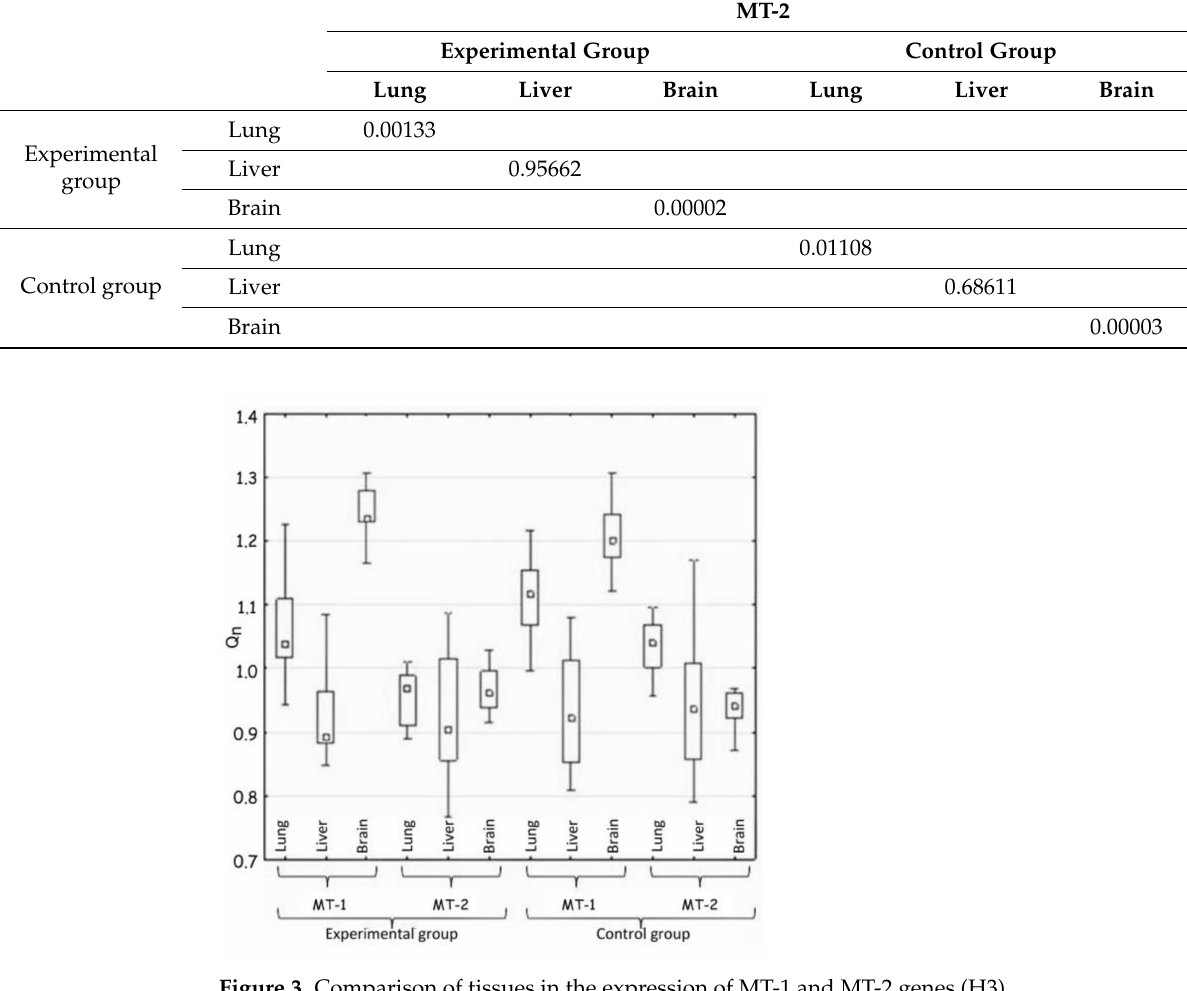
Figure 3. Comparison of tissues in the expression of MT-1 and MT-2 genes (H3). Table 4. The result of the Mann-Whitney U test for the significance of differences between tissues in the expression of MT-1and MT2 genes (H3) at p <